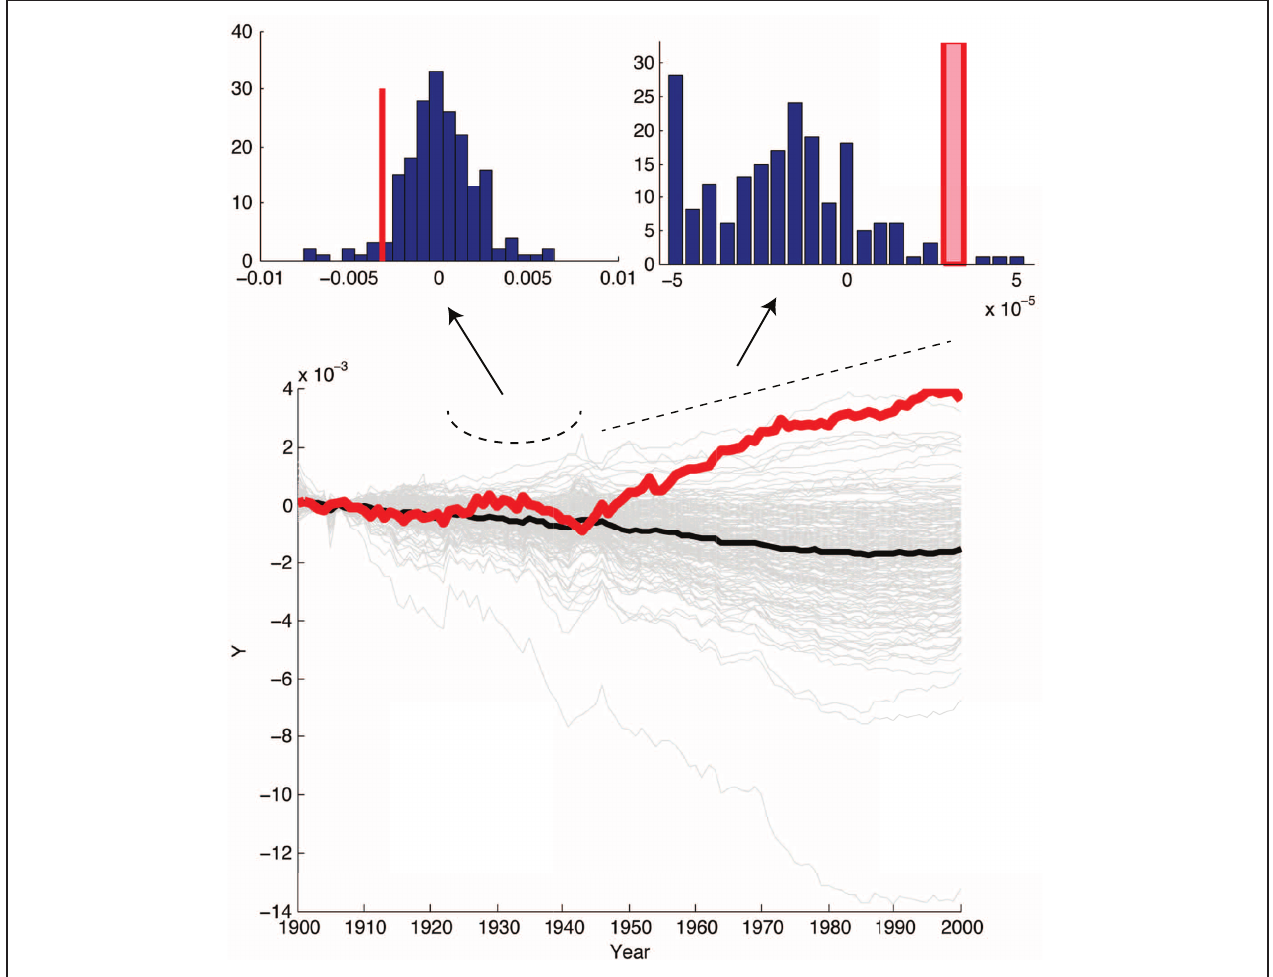
normalized to its mean in the first 10 years (1900–1910). A quadratic term was fit to the period 1914–1939 and a linear term to the period 1945–2000. The inset bar plots show, in blue, the distribution of terms for each of the control words. In red, it shows the corresponding term for